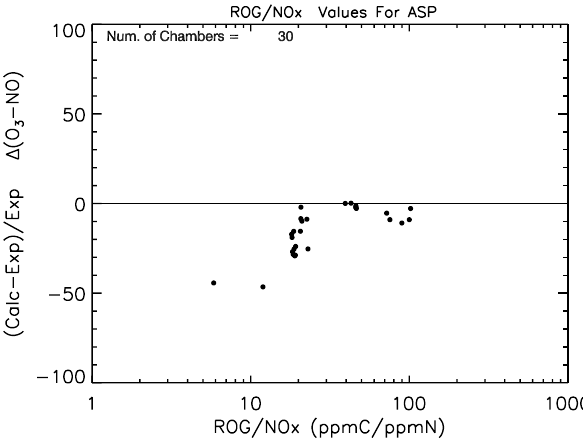
Figure 2. Percentage bias in final (cid:49) ([O 3 ] − [NO]) vs. the initial ratio of reactive organic gases (ROG) to NO x (ppmC / ppmN) for the chamber